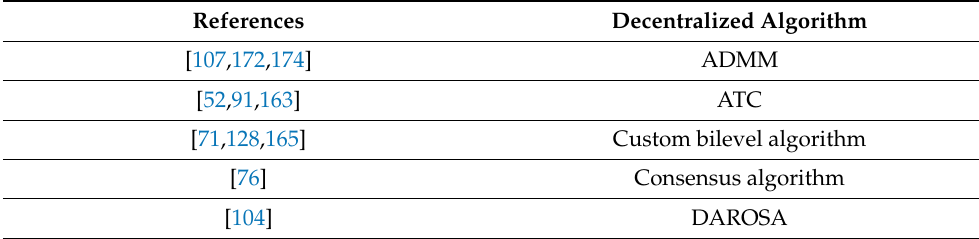
Table 15. Decentralized algorithms employed in the DGS